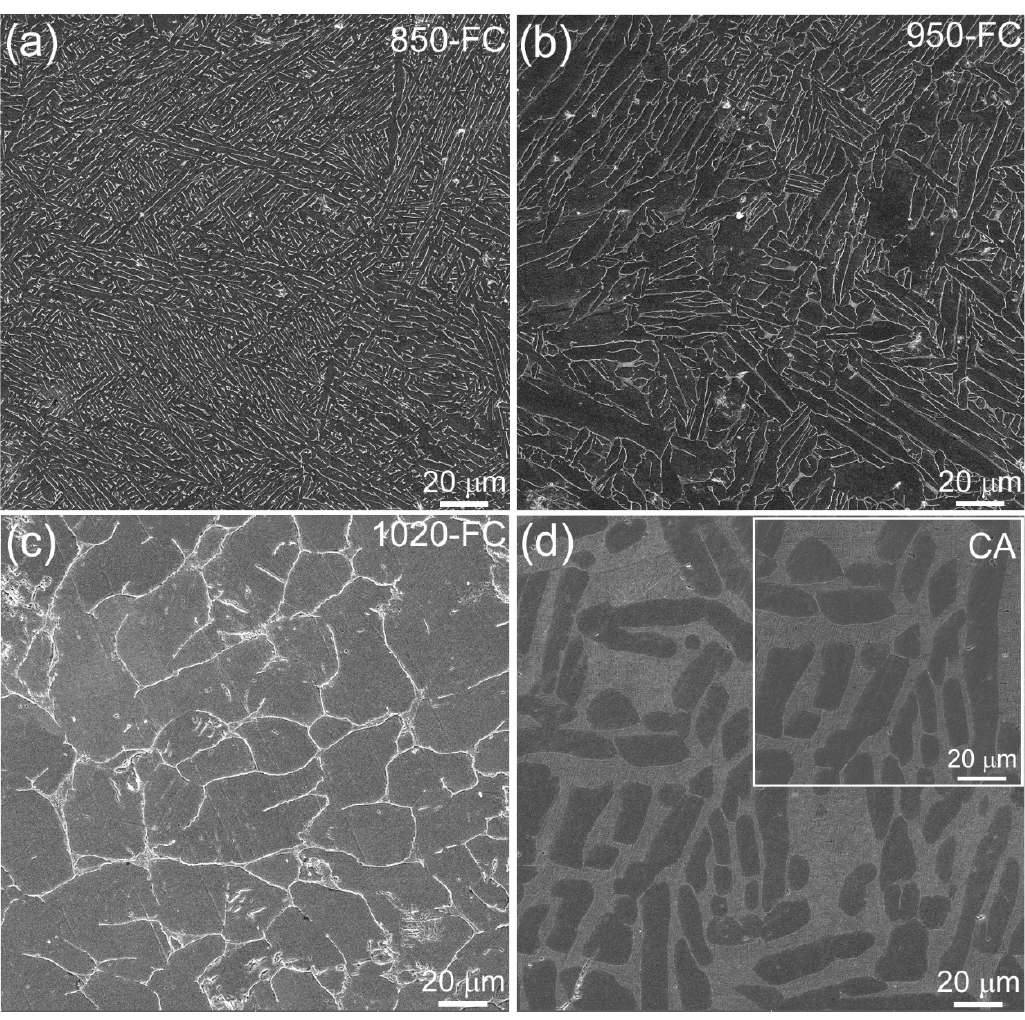
Figure 7. SEM images showing the heat-treated Ti64 specimens for: ( a ) 850-FC, ( b ) 950-FC, ( c ) 1020-FC and ( d ) CA samples.